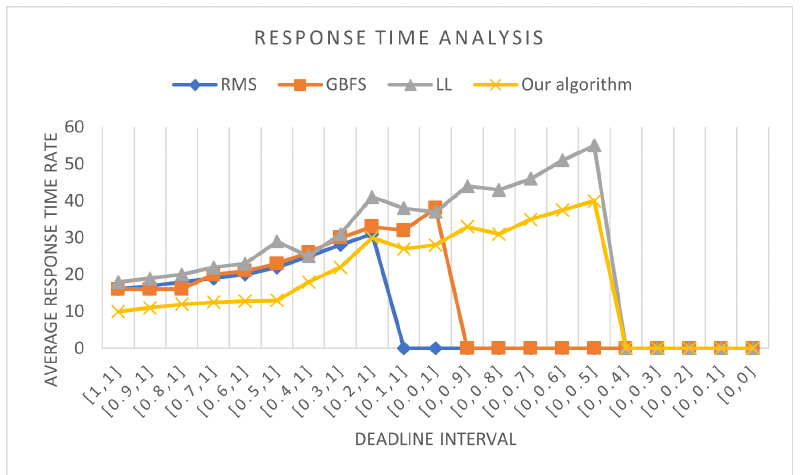
Figure 8. Response time for different